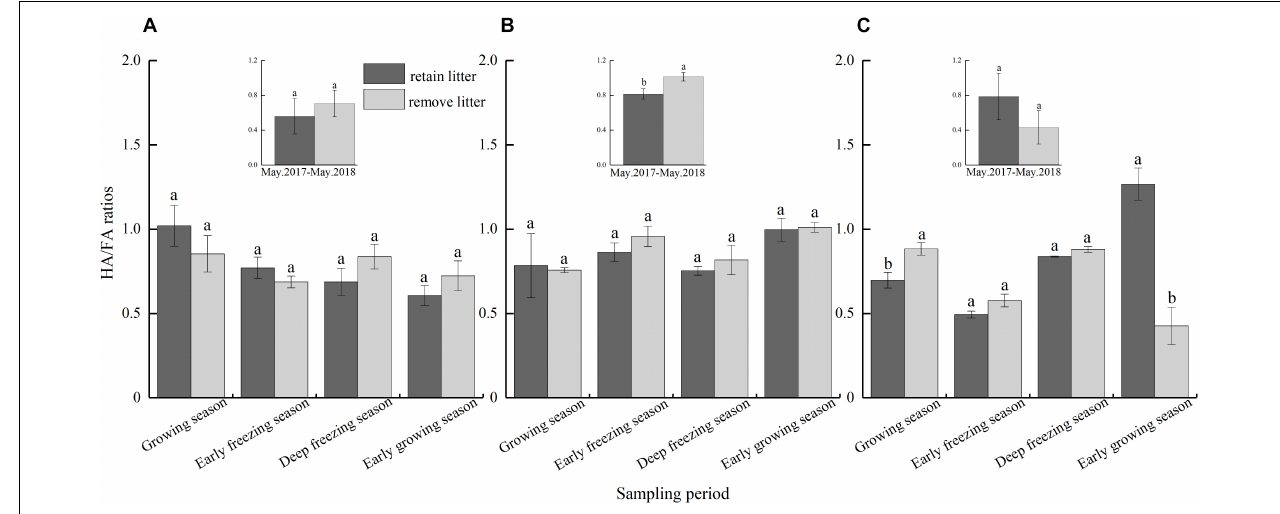
FIGURE 6 | The HA/FA ratios as affected by litter removal at different periods in the (A) coniferous forest, (B) mixed forest, and (C) broadleaved forest. The histograms show the averaged values over 1 year. The presented content values are the means of 3 observations; the error bars represent standard errors. Lowercase letters represent significant differences in the contents of total extracted humus between the different litterfall treatments. TABLE 3 | Correlation analyses between the total extracted humus, HA, FA, HA/FA ratios and environmental factors with different litterfall treatments. Soil retained litter Soil removed